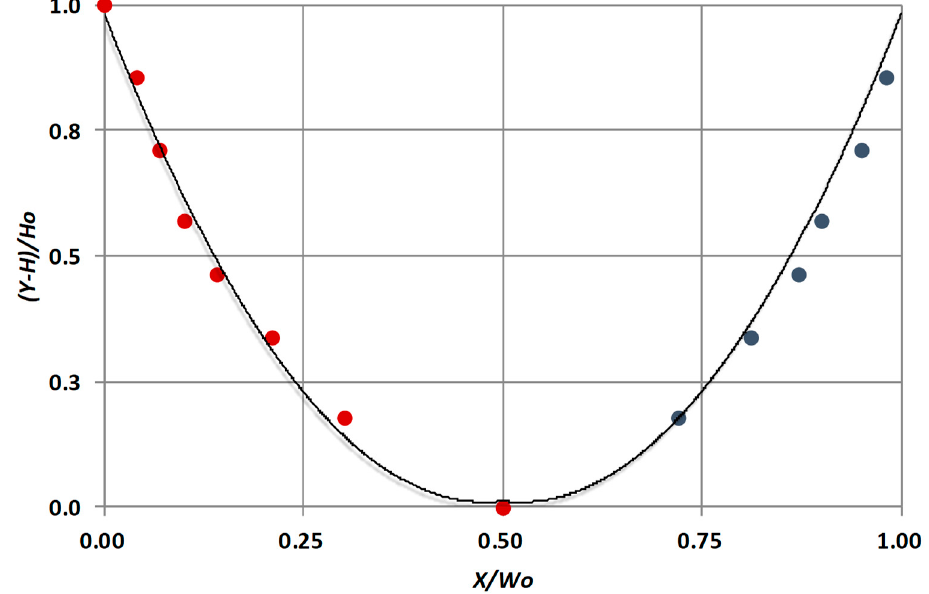
Figure 5. Typical measurements of the liquid film (nW, 40 mL/h, inclination angle 25°) where X is the distance from vertical wall and Y the distance from the channel bottom.